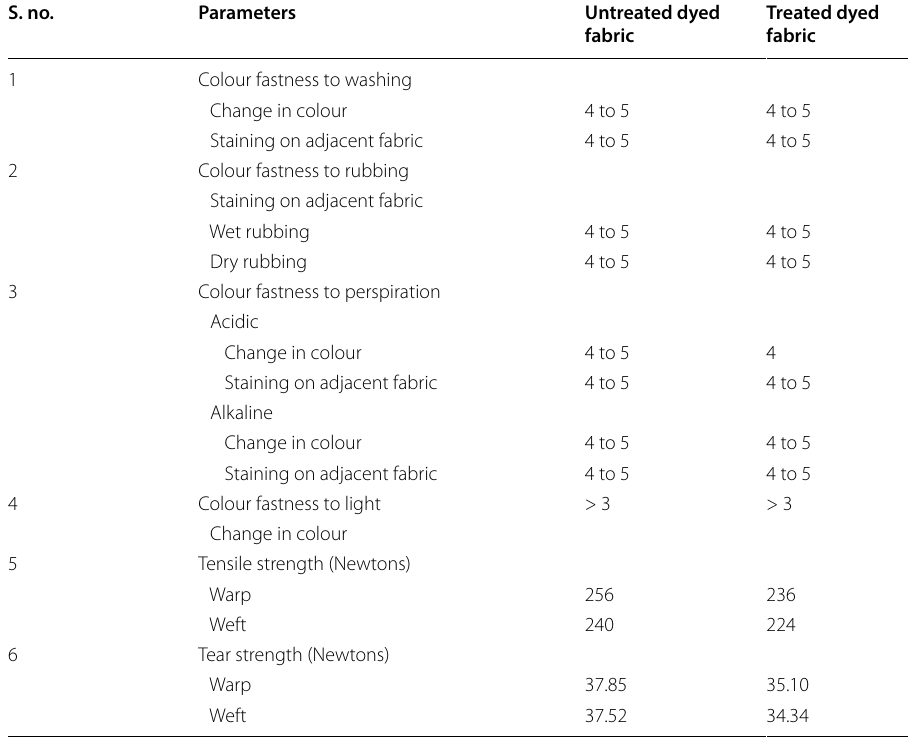
Table 2 Comparison of fabric properties between untreated and treated dyed cotton S.